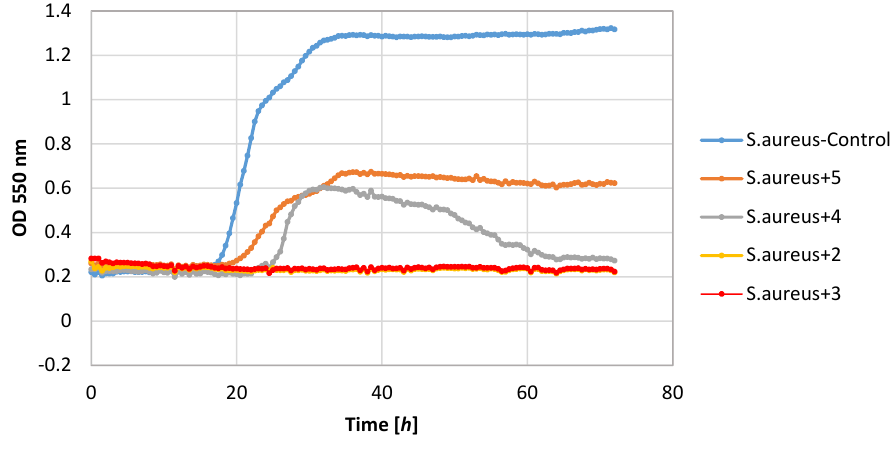
Figure 2. The assessment of the effects of the lactones 2 – 5 on the growth of S. aureus. (OD ‐ Optical Density was measured for λ 550 nm).